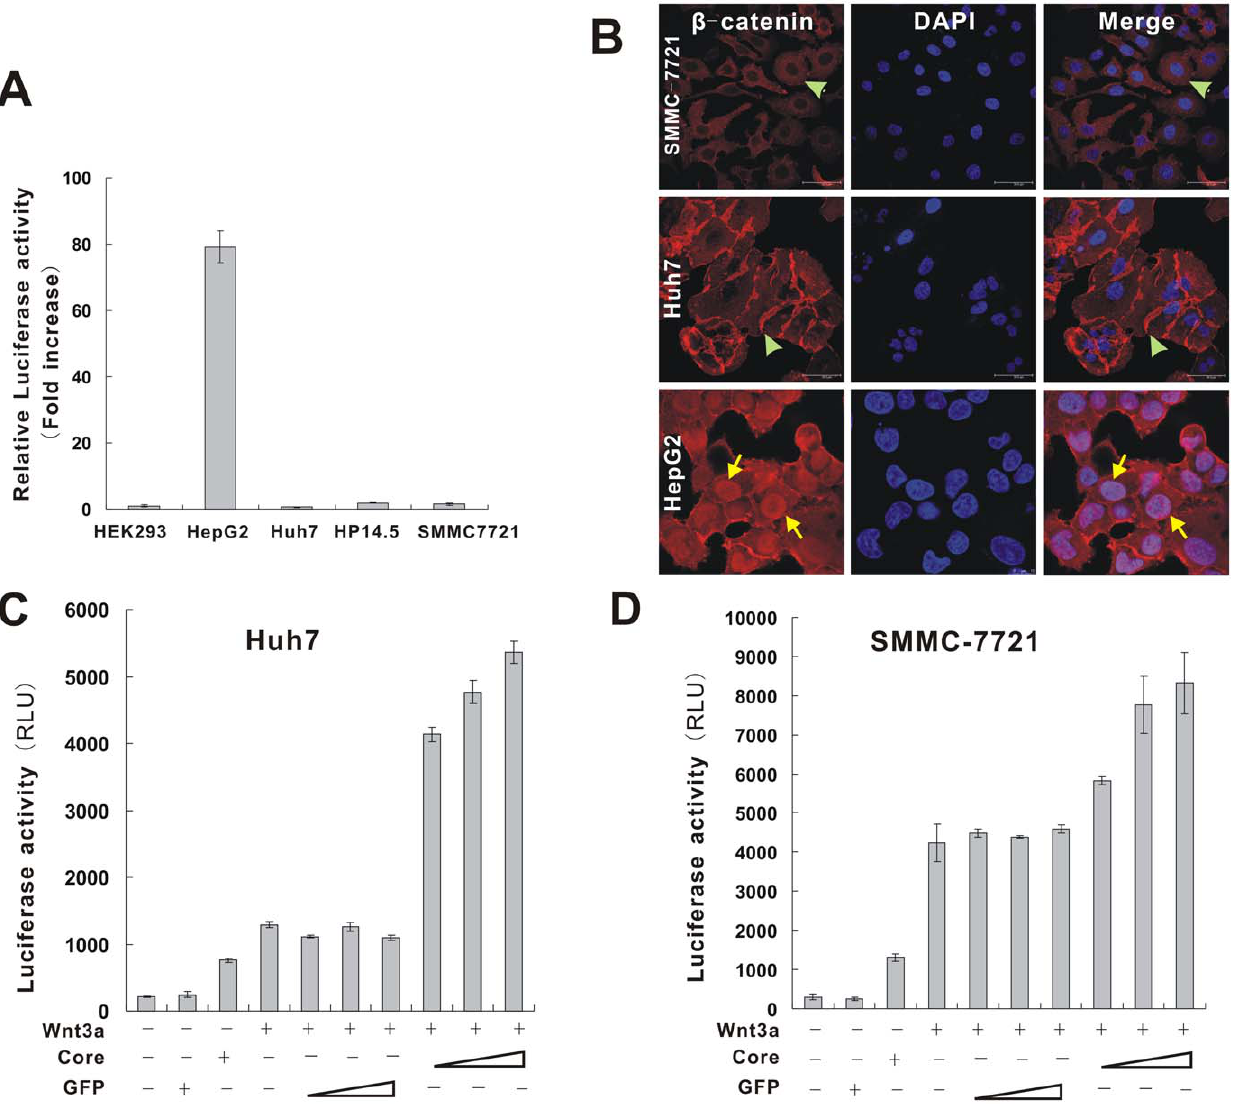
Figure 1. HCV core potentiates Wnt3A-induced TOP-Luc activity in hepatoma cells. ( A ) Endogenous Tcf-4-dependent transcriptional activity in different hepatoma cell lines. HEK293, mouse hepatic progenitor cells (HP14.5) and hepatoma cell lines (HepG2, Huh7, SMMC-7721) were transfected with Tcf4/LEF1 reporter pTOP-Luc. At 24 hr after transfection, cells were collected for luciferase assays. Data were present as mean 6 S.D. Fold activation was calculated by dividing the relative luciferase activity of hepatic lines’ with that of HEK293 cells’. ( B ) Cellular localization of b - catenin in SMMC-7721, Huh7 and HepG2 cells. Subconfluent cells were fixed and stained with an anti- b -catenin antibody (Santa Cruz Biotechnology) and a fluorescence-labeled secondary antibody. Cells were counterstained with 4 9 , 6-diamidino-2-phenylindole (DAPI) to label nuclei. The presence of b -catenin was visualized under a confocal immunofluorescence microscope. Membrane or cytoplasm stains were indicated by green arrows and nuclear stains were indicated by yellow arrows. ( C ) ( D ) HCV core activated Tcf-4-dependent transcription in Huh7 and SMMC-7721 cells. Cells were transfected with pTOP-Luc and then infected with AdGFP control, Ad-Core, AdWnt3A, AdWnt3A plus AdGFP or AdWnt3A plus Ad-Core. At 24 hr post infection, cells were collected for luciferase assays. Data are present as means 6